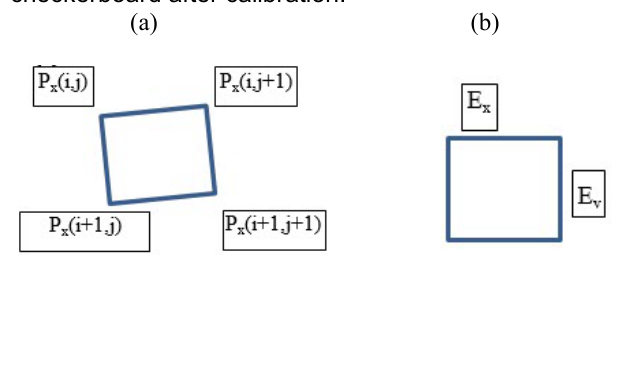
Figure 5. (a) Shrinkage distribution in X-axis; (b) Shrinkage distribution in Y-axis; (c) The image of the checkerboard before calibration; (d) The image of the checkerboard after